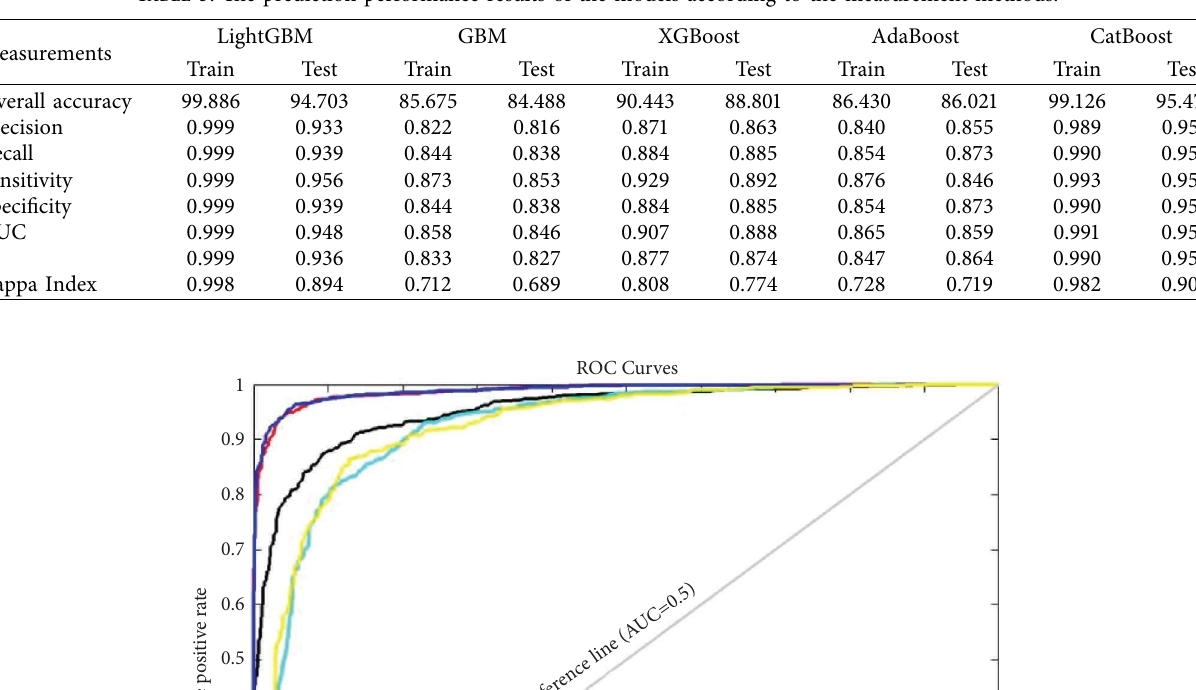
Table 5: Te prediction performance results of the models according to the measurement methods.